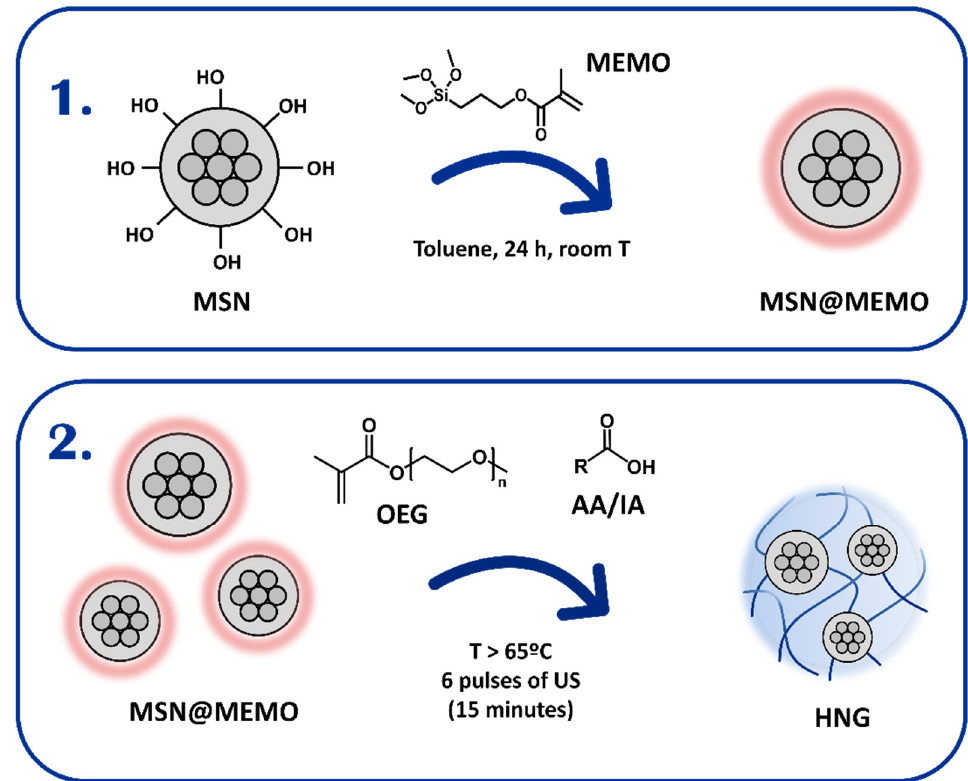
Figure 2. Scheme of the synthesis steps: surface silanization of MSNs ( 1 ) and polymerization ( 2 ) to produce HNGs.